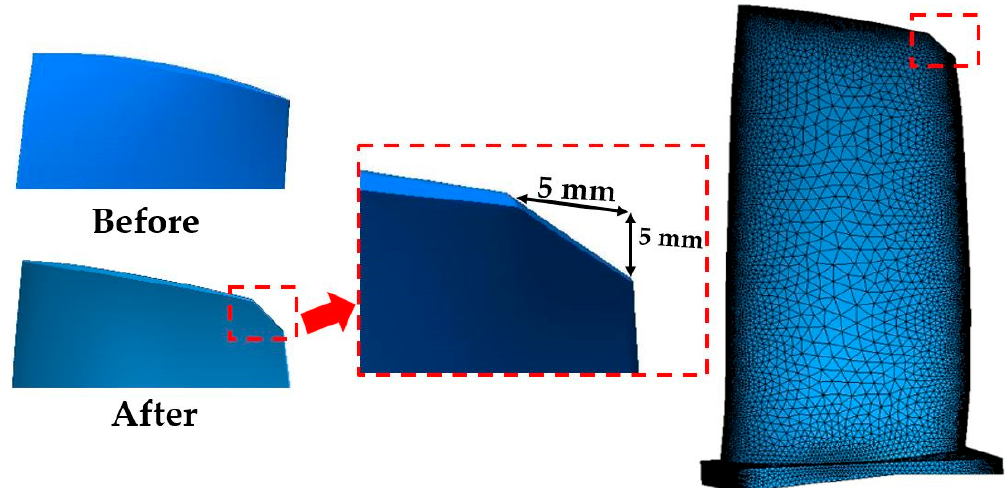
Figure 4. Shape of a rotating axial compressor blade and surface mesh model.